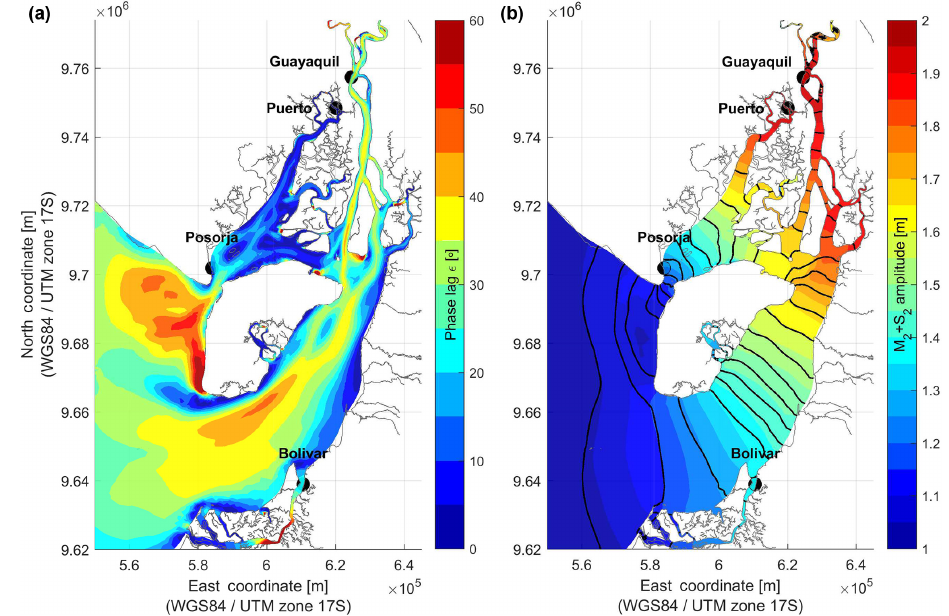
Figure 4. Phase lag between high water and high-water slack (a) , tidal amplification, and propagation throughout the Gulf of Guayaquil (cotidal lines mapped every 10min) (b) .